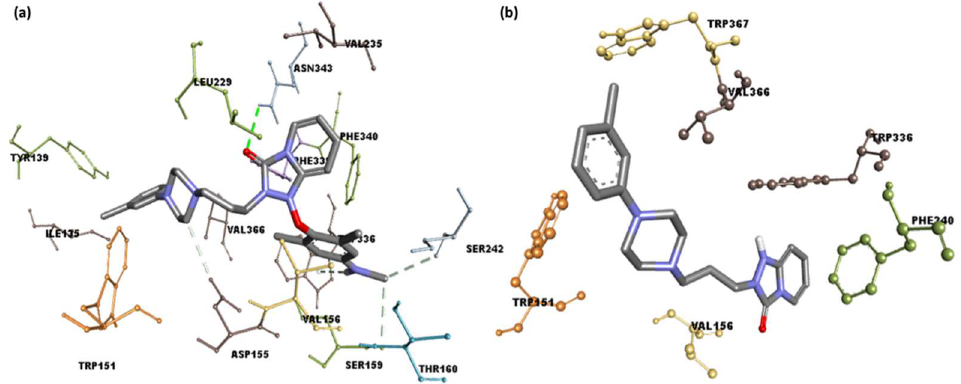
Figure 10. 3D structure of interactions between serotonin docked with ( a ) [(TZD)(DCQ)] or ( b ) TZD drug alone.